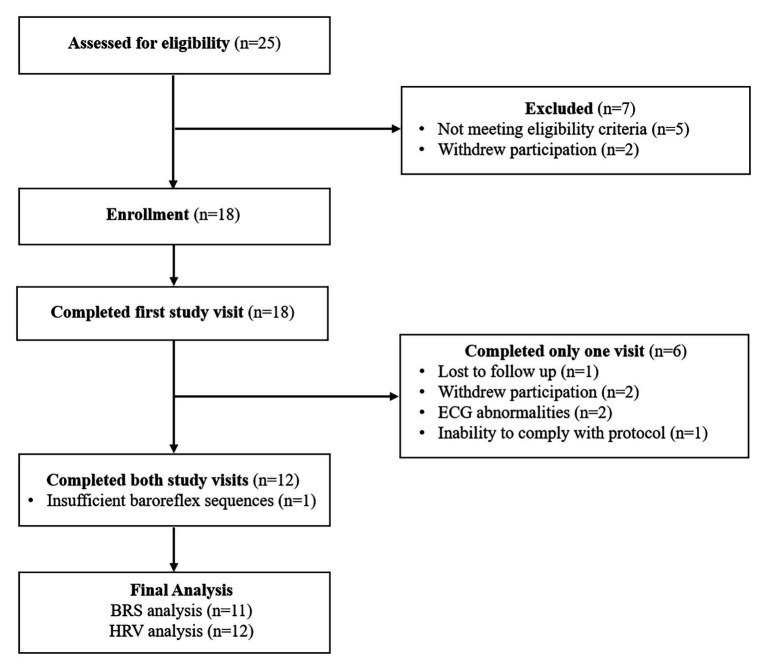
Consortium diagram. Participant disposition for the study protocol showing reasons for exclusion and ineligibility. ECG abnormalities included premature atrial and ventricular contractions occurring during greater than 3% of the total heart beats in the measurement period. The participant who was unable to comply with the study protocol was not able to slow down their respiratory rate to 6 breaths/min.